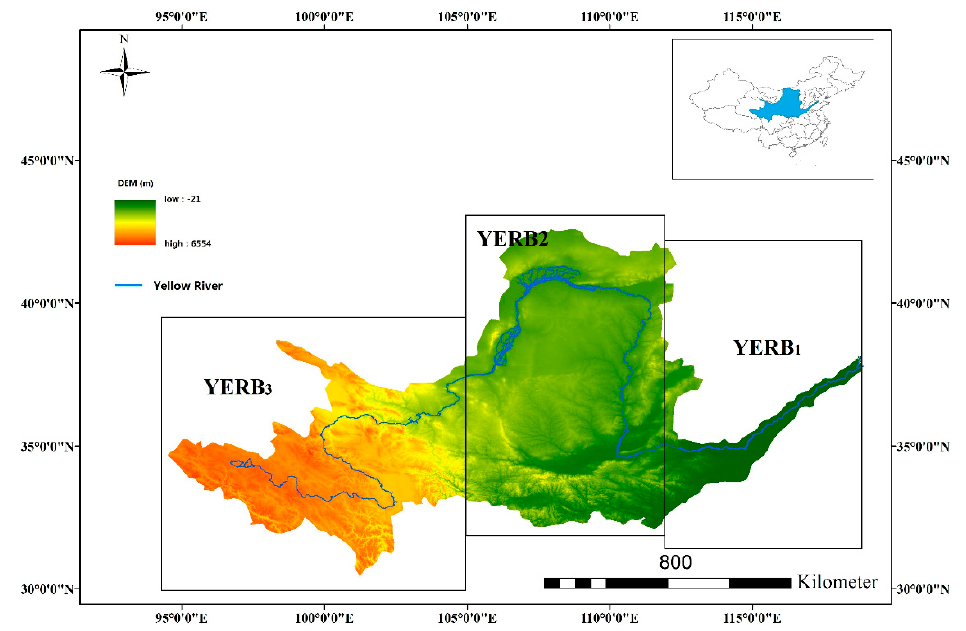
Figure 1. Geographical locations of the Yellow River Basin (YERB). The color bar represents the altitude (elevation).